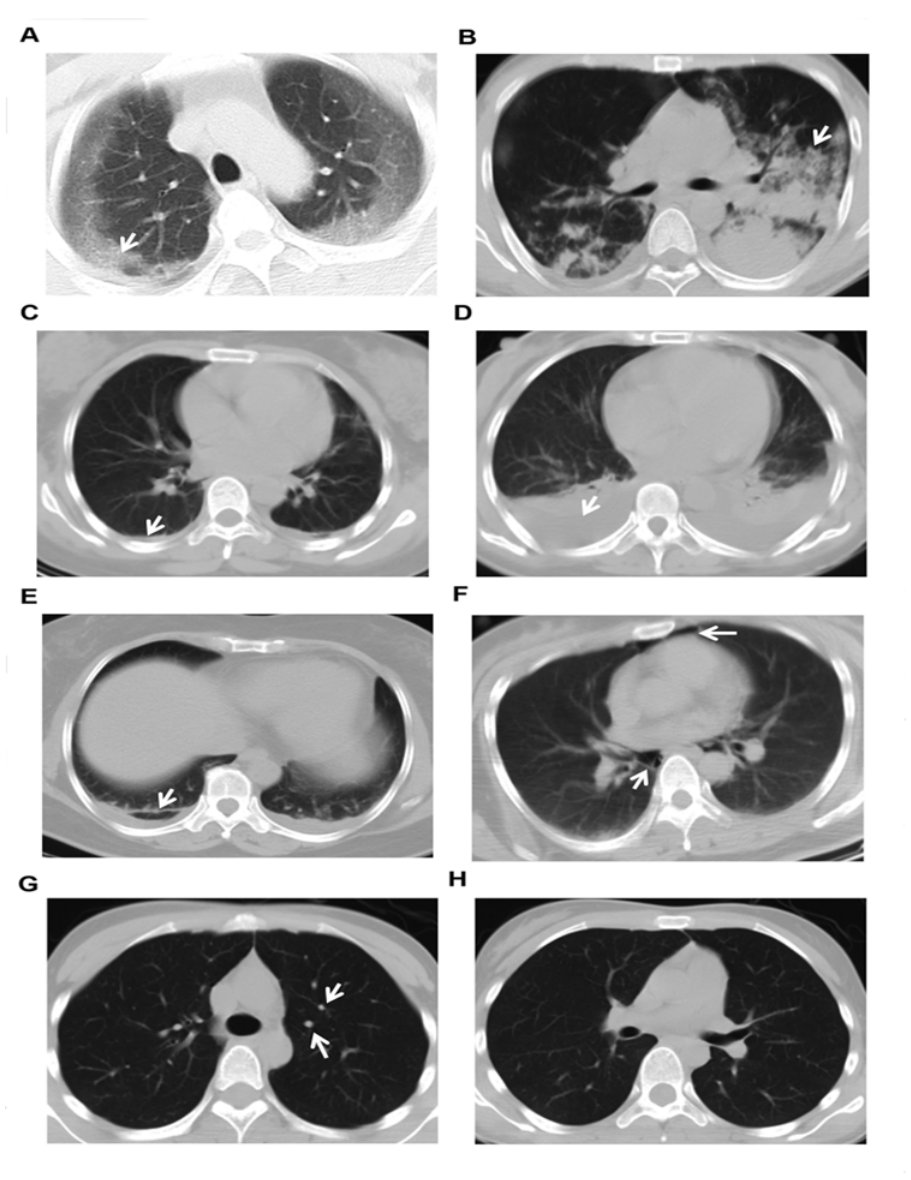
Fig 2. Eight CT findings of PQ poisoning captured within the first 5-day. A. ground glass opacity (GGO); B. consolidation; C. pleural thickening; D. hydrothorax; E. fibrosis; F. pneumomediastinum; G. nodule; H. “ no obvious lesion ” . Arrows represented the